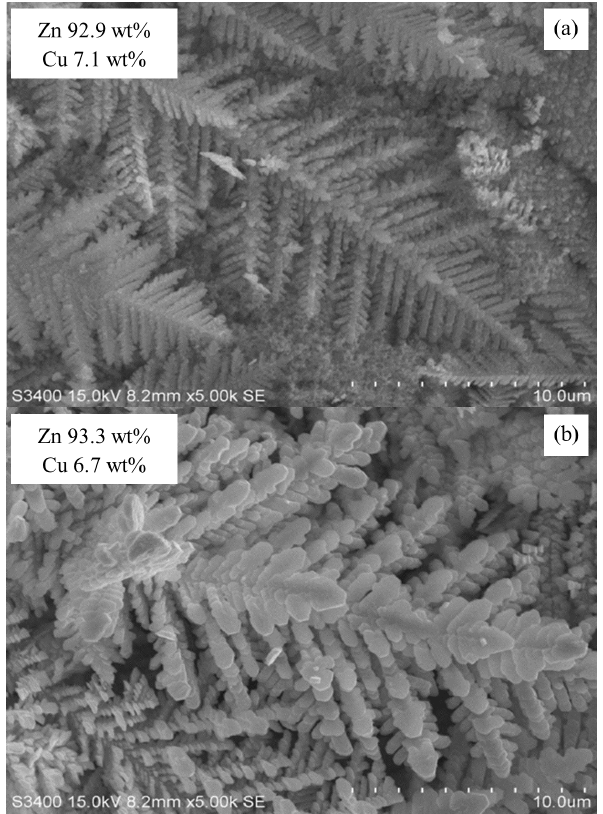
Figure 8. SEM images of Zn/Cu–Na200 ( a ) before and ( b ) after the stability test.